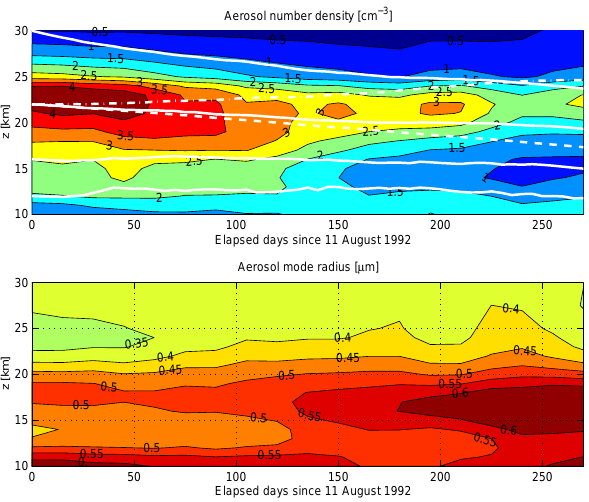
Fig. 6. Top: Retrieved aerosol number density evolution along the z = 22km trajectory. Bottom: retrieved(circles) and com- puted(crosses) mode radius evolution for the same